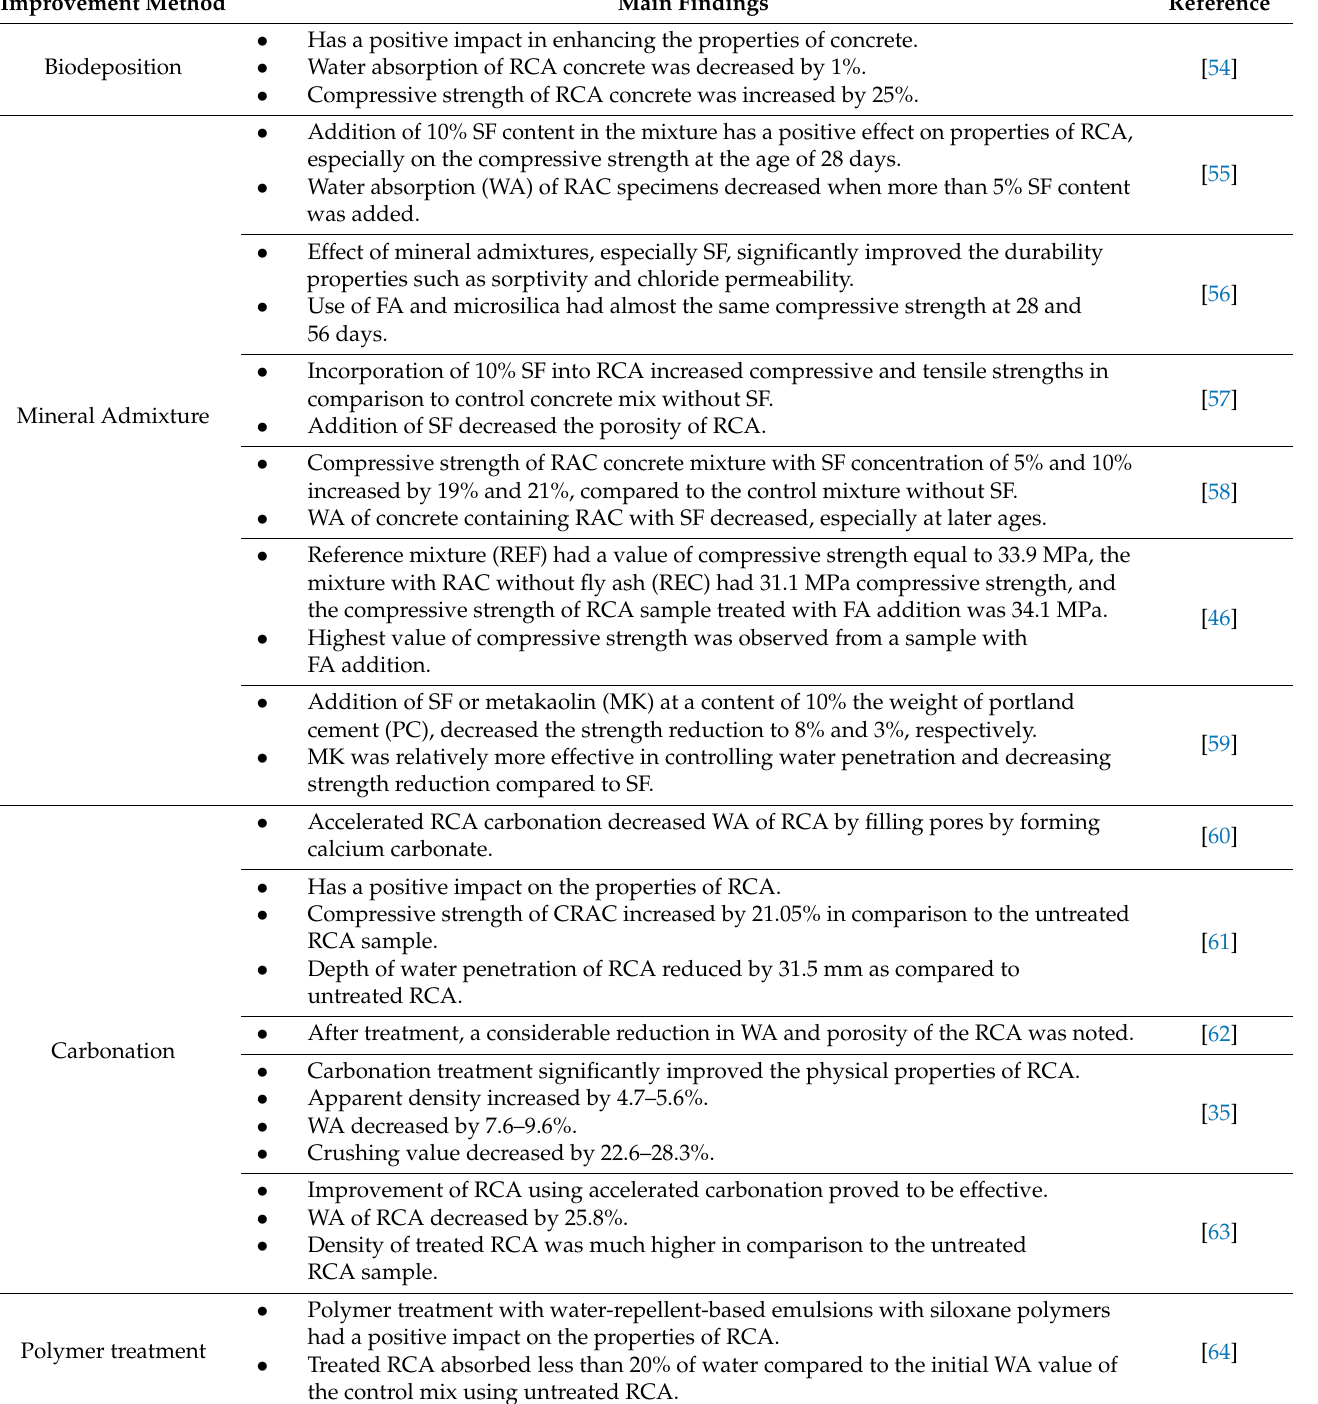
Table 7. Methods for improving properties of recycled aggregate